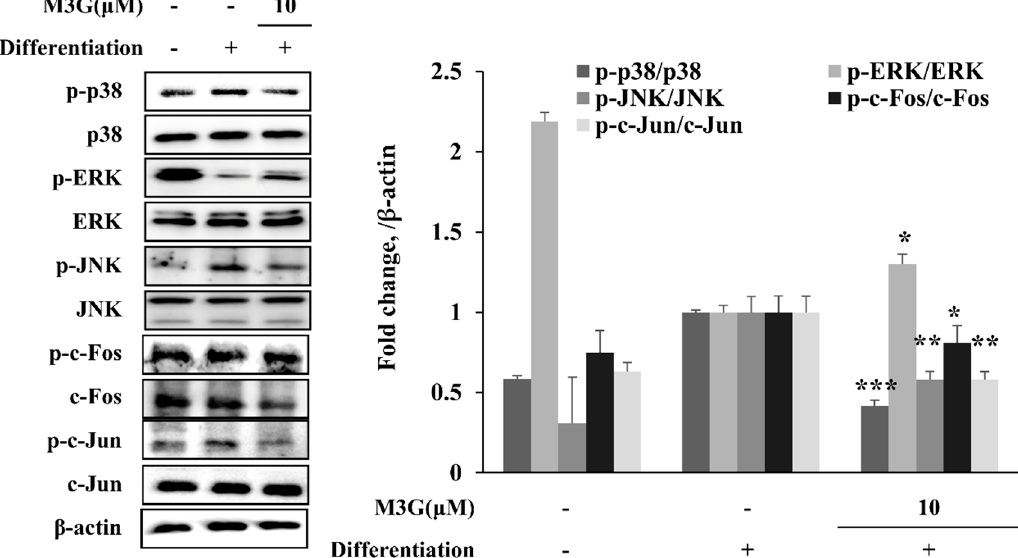
Figure 8. Effect of M3G on the MAPK/AP-1 signaling. Analysis of MAPK and AP-1 activation and was carried out with Western blotting of whole-cell lysates of adipo-induced hBM-MSCs at day 10 of differentiation. M3G was treated with initial differentiation for 3 days. β -actin was used as an internal loading control. * p < 0.05, ** p < 0.01, *** p < 0.001 vs. differentiated untreated group.